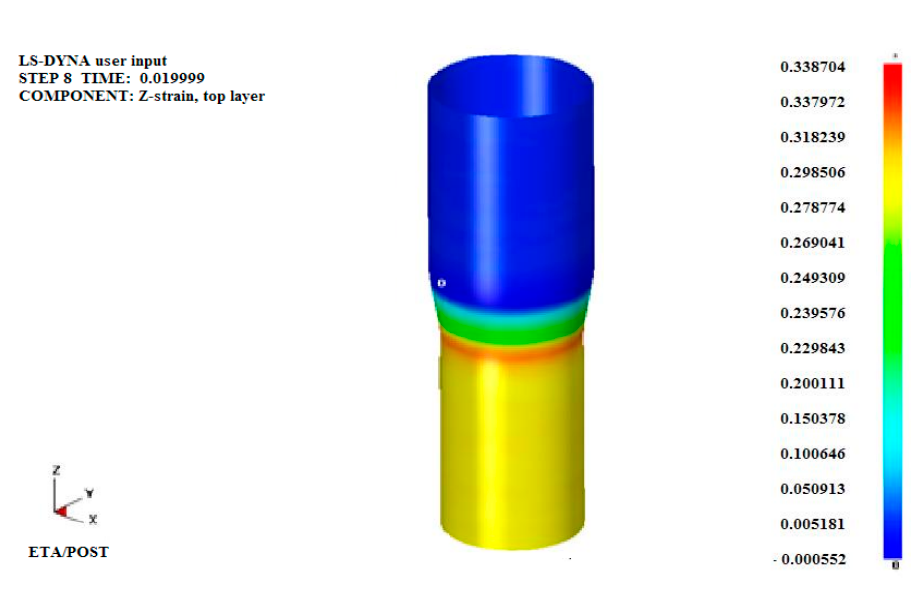
Figure 14. Drawing force at the third draw F = 0.310 kN.